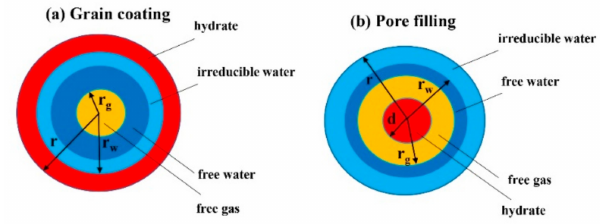
Figure 5. Two filling modes under gas–liquid